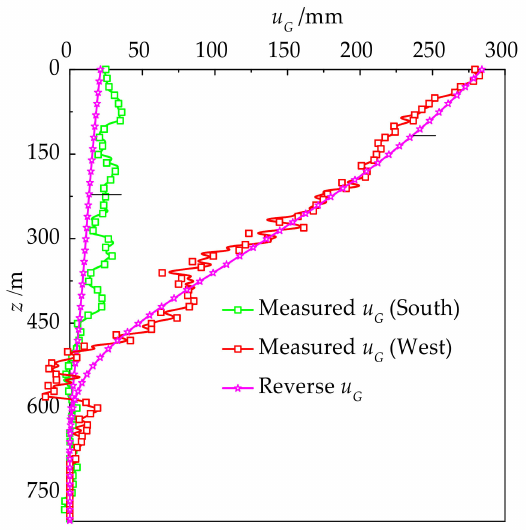
Figure 6. Measured and reverse values of the horizontal displacement (2015.6).